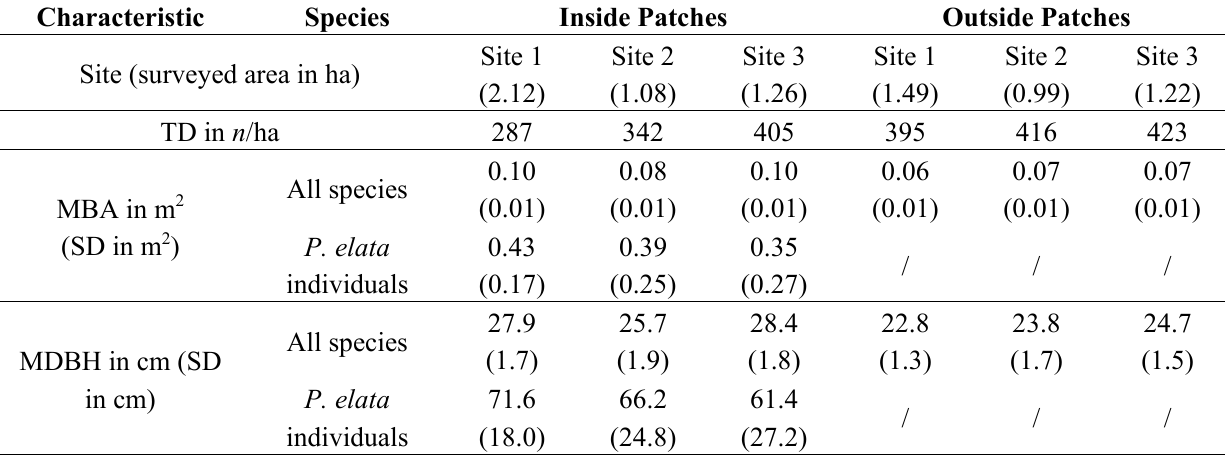
Table 1. Some characteristics of the standing vegetation (trees with dbh ≥1 0 cm) in the study sites (1–3). TD, tree density; MBA, mean basal area; MDBH, mean diameter at breast height. Means are computed over all recorded stems per site and zone (the standard deviation (SD) is given between brackets). Tree density is reduced per ha taking into account the surveyed area in the given site and zone. No regeneration (dbh < 10 cm) was detected for P. elata.